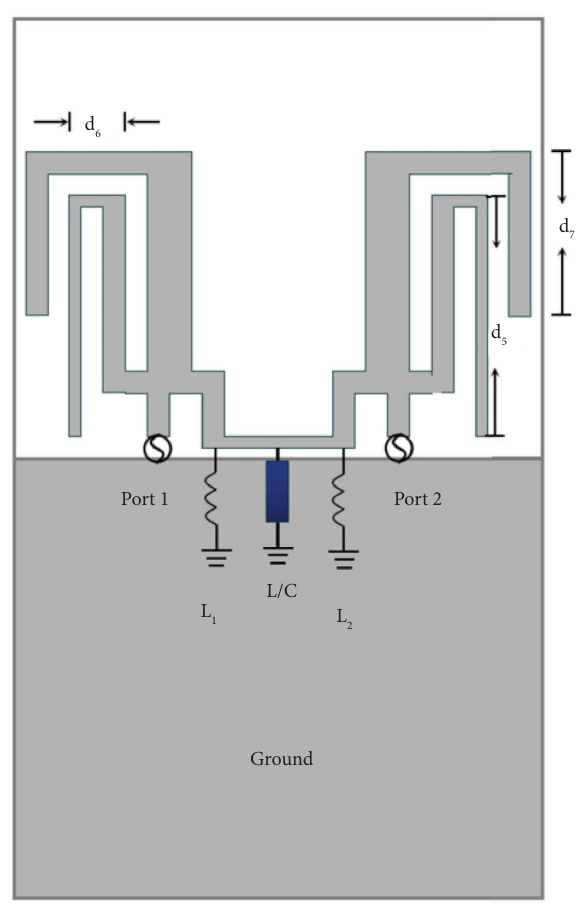
Figure 7: Geometry of the proposed dual-frequency decoupling antenna system.